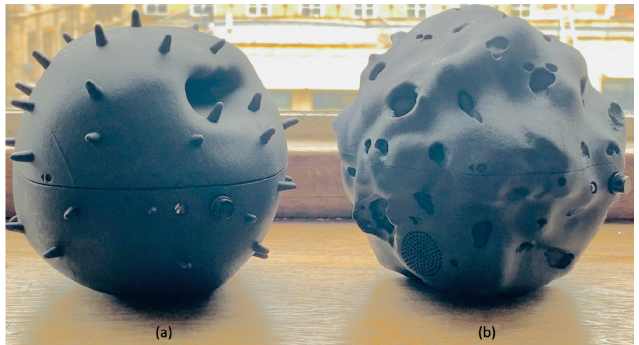
Figure 2. Dustbox 2.0 shapes: ( a ) pollen particle and ( b ) diesel char